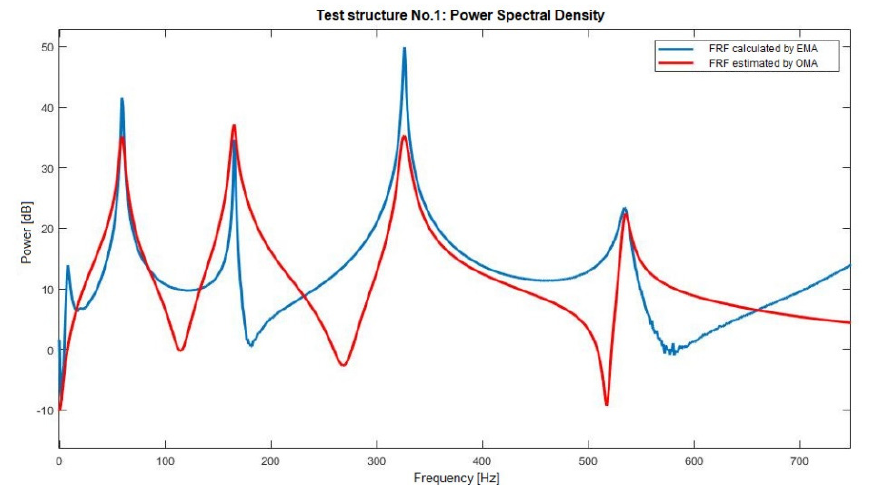
Figure 8. Structure natural frequencies of OMA vs. EMA techniques for a steel bar .